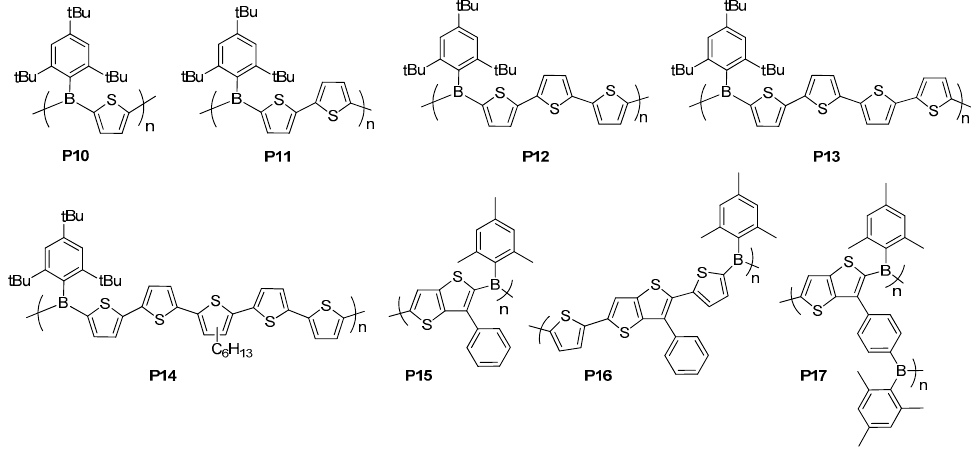
Figure 17. Triarylborane-based π -conjugated polymers P10 – P17 .